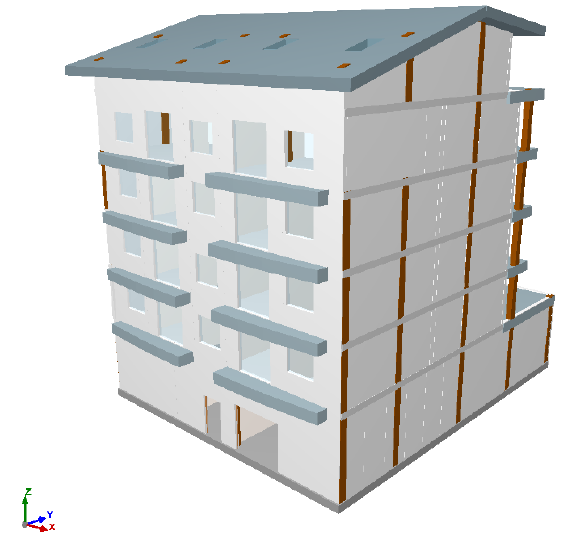
Figure 6. 3D model of the simulated building.